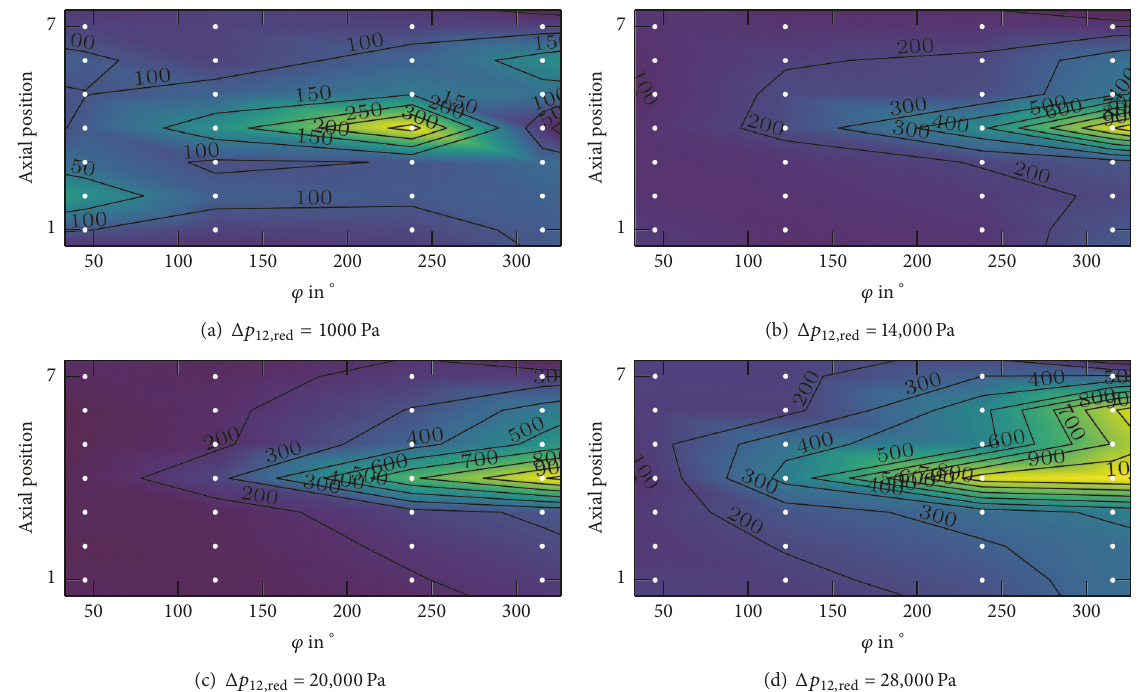
Figure 18: Standard deviation of wall pressure ̌𝑝 𝑥,𝜑 at a rotational speed of 𝑓 = 50 Hz for four different operating